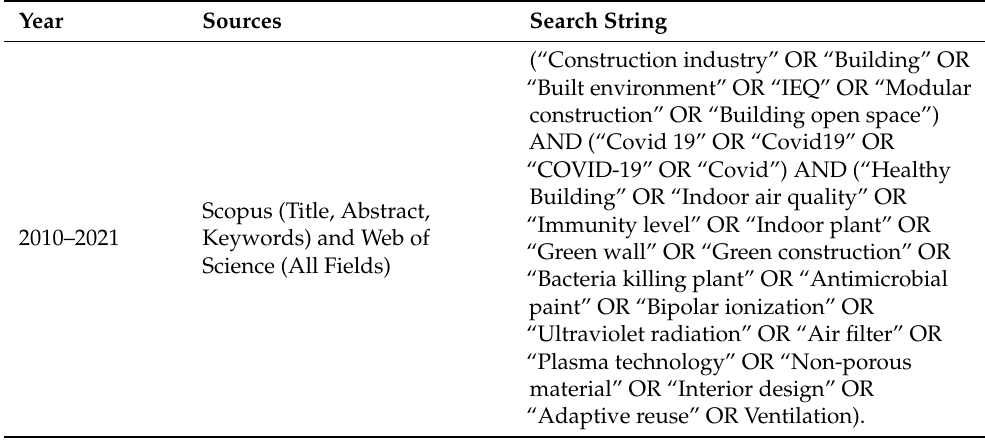
Table 1. The search string used in this review.